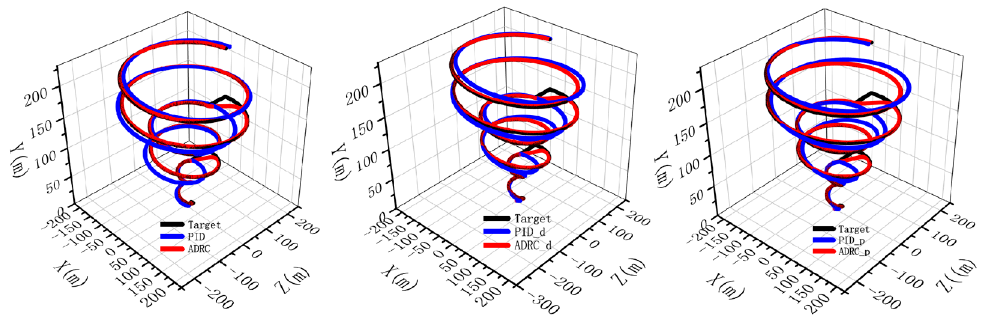
Figure 17. Spiral climb 3D trajectory response.